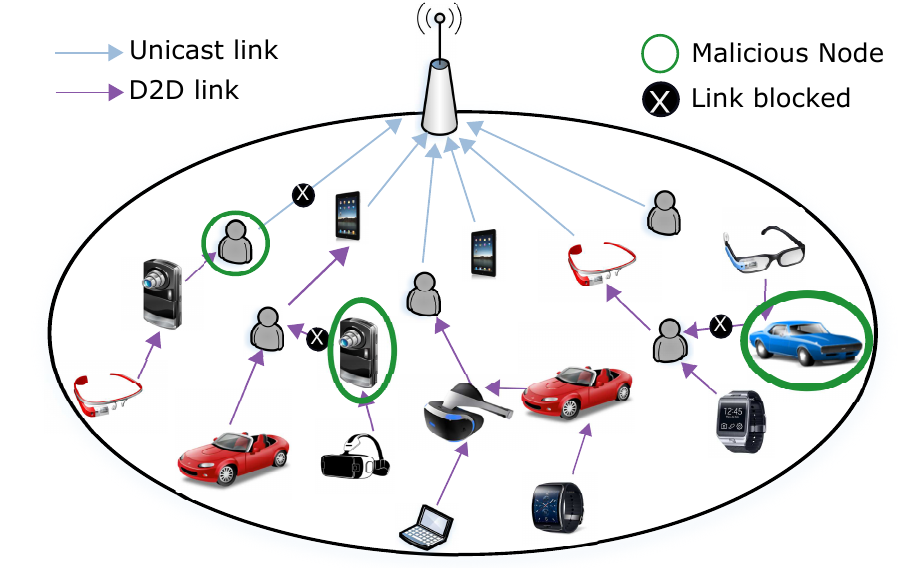
Figure 1. Cooperative multihop content uploading based on trustworthy device to device (D2D) links.